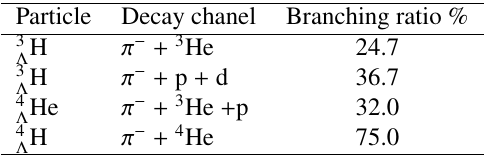
Figure 2. Event topology of two-particle decays of a charged particle (e.g. 3 Λ H → 3 He + π − ). Here dca 1 and dca 2 are the distances of the closest approach of the decay tracks to the primary vertex PV , dca 12 is the distance between daughter tracks in the decay vertex V M , dca M is the distance of the closest approach of the mother particle to the primary vertex, path is the decay length, p 1 and p 2 are the momenta of daughter particles Table 1. Hypernuclei decay modes and branching ratios under study